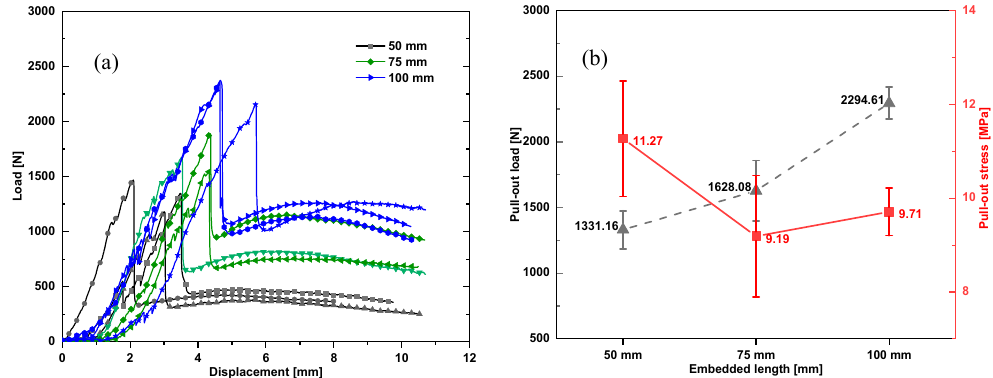
Figure 6. Results of the pull-out test: ( a ) Load–displacement curves of the fiber yarn embedded geopolymer matrix; ( b ) the average values of the pull-out load and the average values of the pull-out stress.